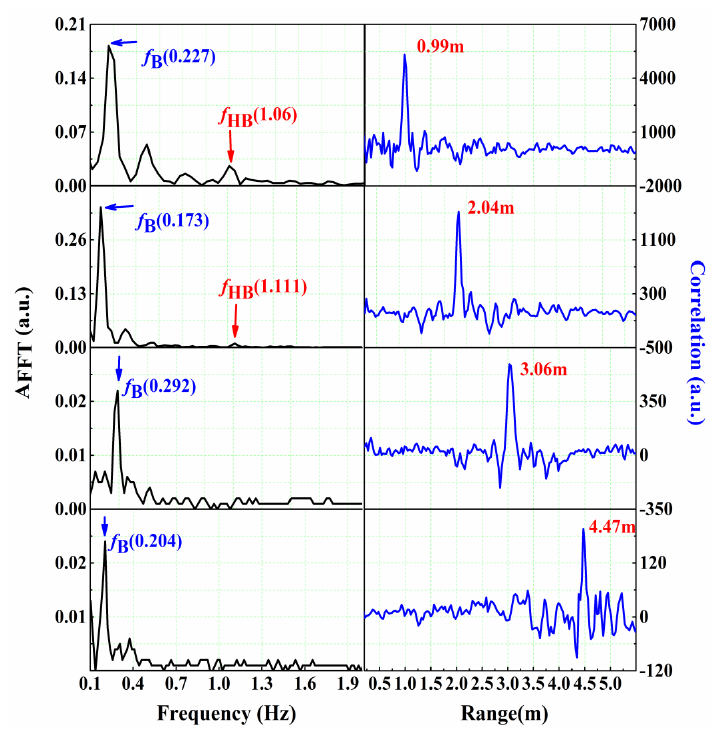
Figure 5. Experimental results in free space for human located at 1, 2, 3, 4.5 m.